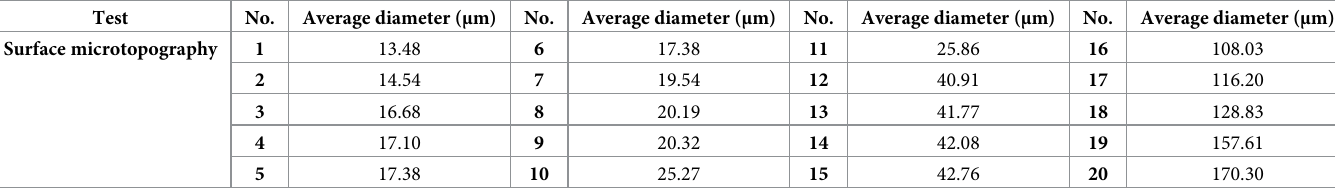
Table 2. Surface roughness of the 20 pieces of RTV.